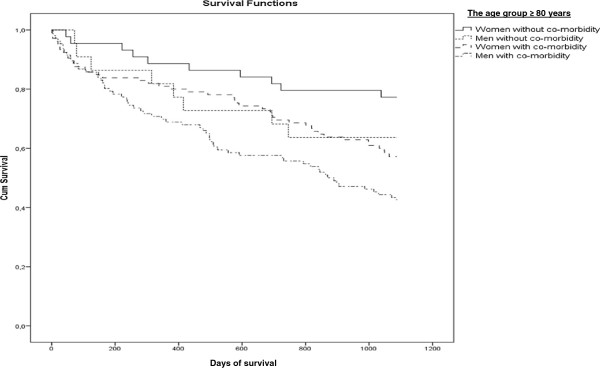
Kaplan-Meier plot: Days of Survival up to 3 Years (1096 days) in the Age group ≥ 80 years by Gender and with or without Co-morbidity (elevated Charlson Index or not).